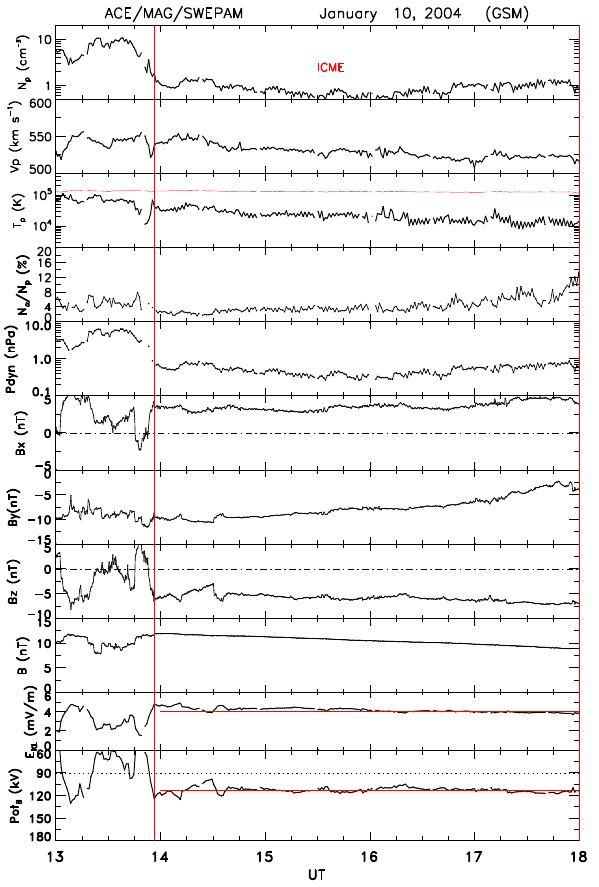
Fig. 1. Interplanetary parameters obtained from ACE during the in- terval 13:00–18:00UT. Panels from top to bottom shows: (i) proton density, (ii) bulk speed, (iii) proton temperature, (iv) the alfa/proton density ratio), (v) dynamic pressure, (vi)–(ix) magnetic field com- ponents B x , B y , B z , and the total field, (x) the geoeffective in- terplanetary electric field, E KL , and (xi) the Boyle potential. The ICME front boundary is marked by vertical guideline.